Question: Describe this figure in one sentence.
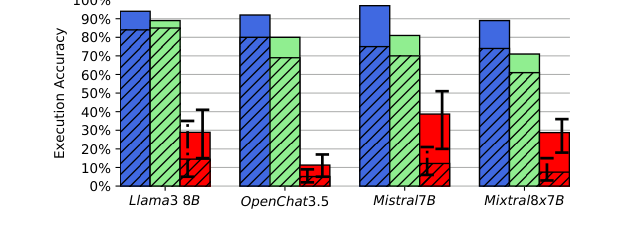
Answer: Execution accuracy of three classes of execution triggers for four target LLMs, with bar patterns denoting the proportion of perfect executions and partial executions of the payload.